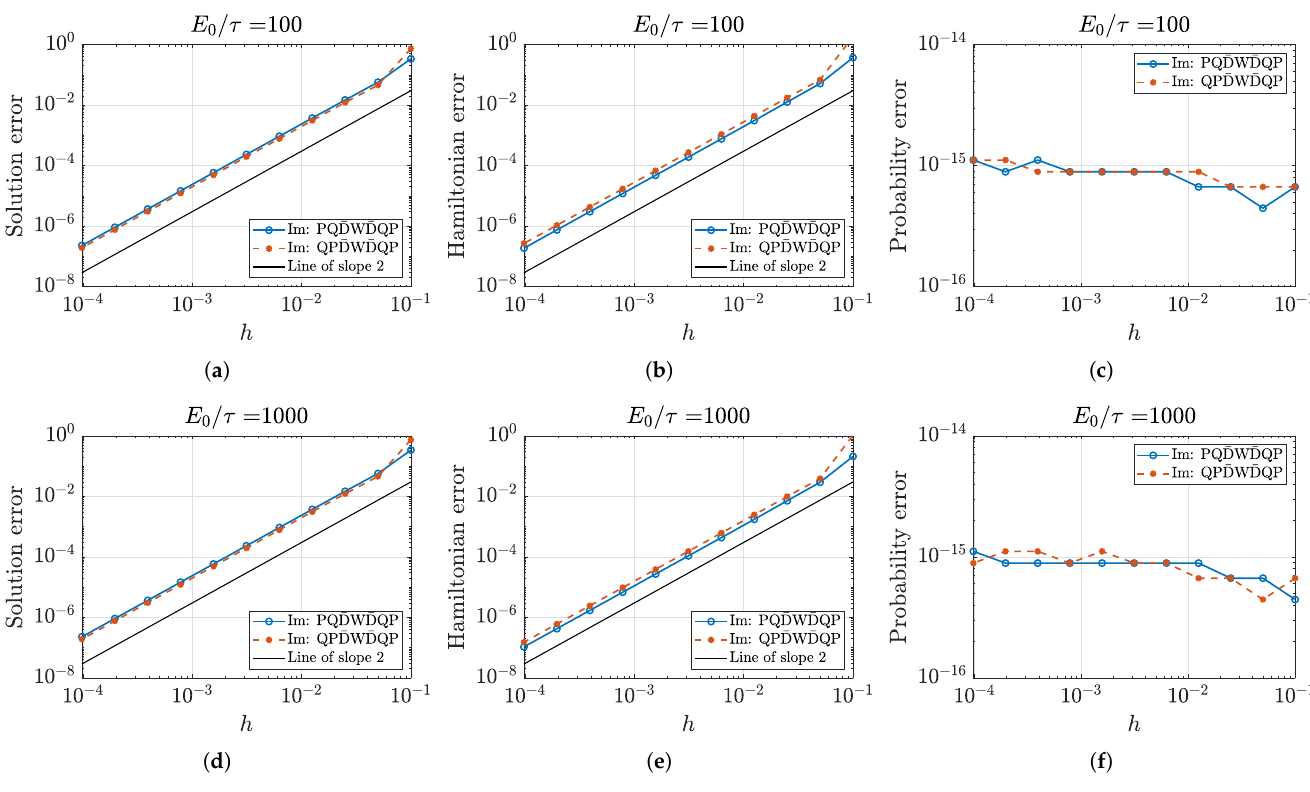
Figure 3. Numerical convergence study of the semi-implicit splitting methods: PQDWDQP and QP ¯DW ¯DPQ. Top ( a – c ): E 0 / τ = 100. Bottom ( d – f ): E 0 / τ = 1000. Left ( a , d ): maximal absolute error of the solution at t = 1. Middle ( b , e ): maximal relative error of the Hamiltonian (42) for t ∈ [ 0,1 ] . Right ( c , f ): maximal relative error of the total charge probability (16) for t ∈ [ 0,1 ] . The numerical solution of reference is computed with the method PQDABADQP and time step h = 10 − 7 and with initial conditions given by the patterns (100) and (101), where γ =